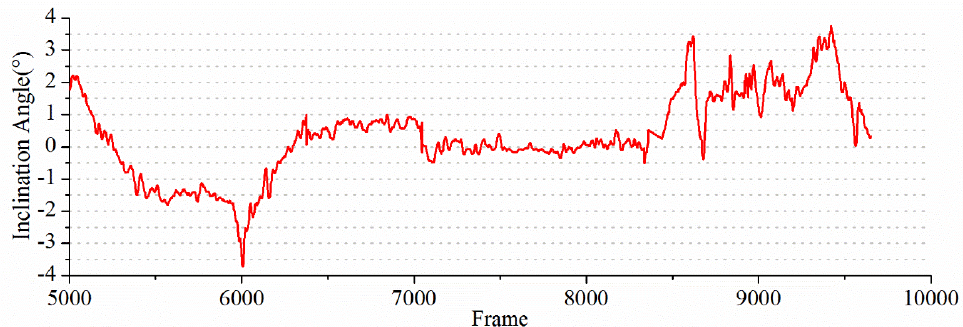
Figure 12. Inclination angle of vehicle.